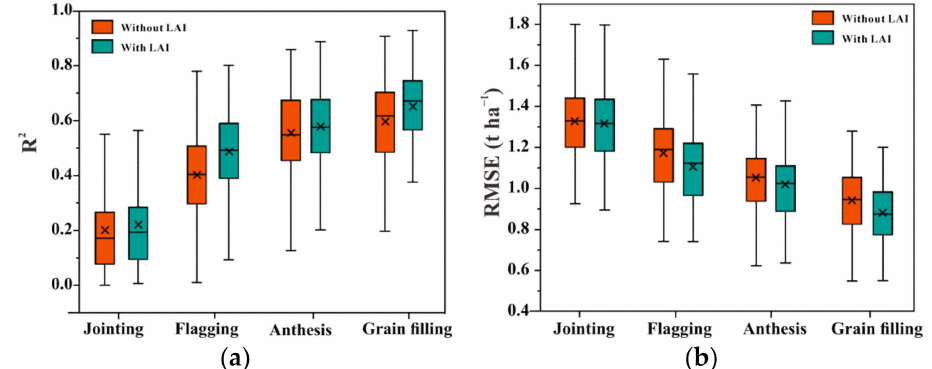
Figure 5. The statistical distributions of the prediction accuracy of each growth stage for grain yield prediction in the test phases; ( a ) distributions of R 2 at each individual stage; ( b ) distributions of RMSE at the each individual